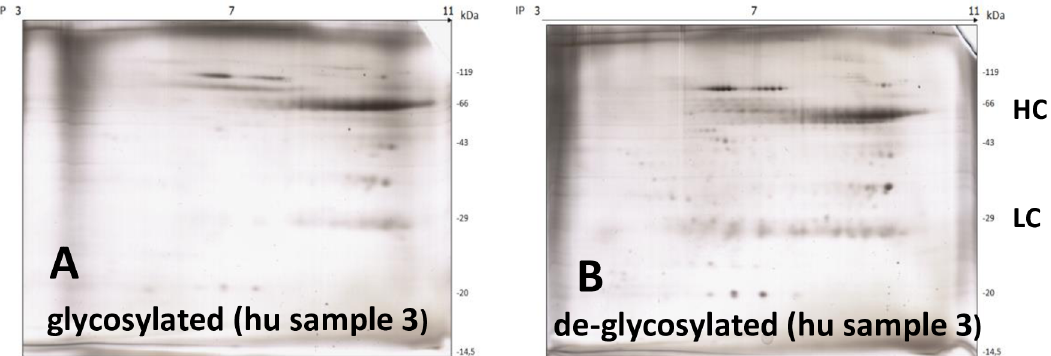
Fig 6. 2DE Gel . A: glycosylated and B: de-glycosylated beta1-AAB enriched human IgG sample. “hu” stands for human. For deglycosylation procedure and gel conditions see under Material and methods.